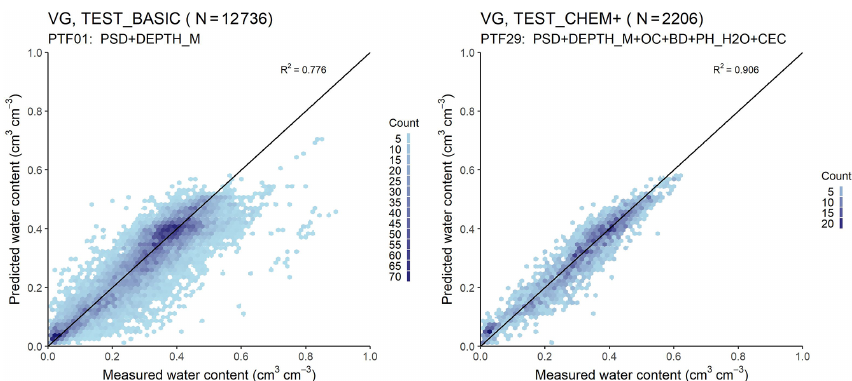
Figure 5. Scatter plot of the measured versus median predicted water retention values computed with the van Genuchten (VG) model (PTF01 vs. PTF29, i.e. the worst versus best performing PTF). PSD: particle size distribution (sand, 50–2000µm; silt, 2–50µm; clay, < 2µm (mass%)); DEPTH_M: mean soil depth (cm); OC: organic carbon content (mass%); BD: bulk density (gcm − 3 ); PH_H2O: pH in water (–); CEC: cation exchange capacity (cmol( + )kg − 1 ); Count: the number of cases in each hexagon.